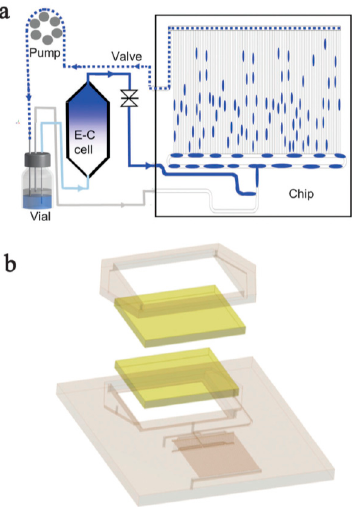
Figure 9. ( a ) Schematic diagram of a segmented flow bioreactor system, ( b ) 3D representation of the